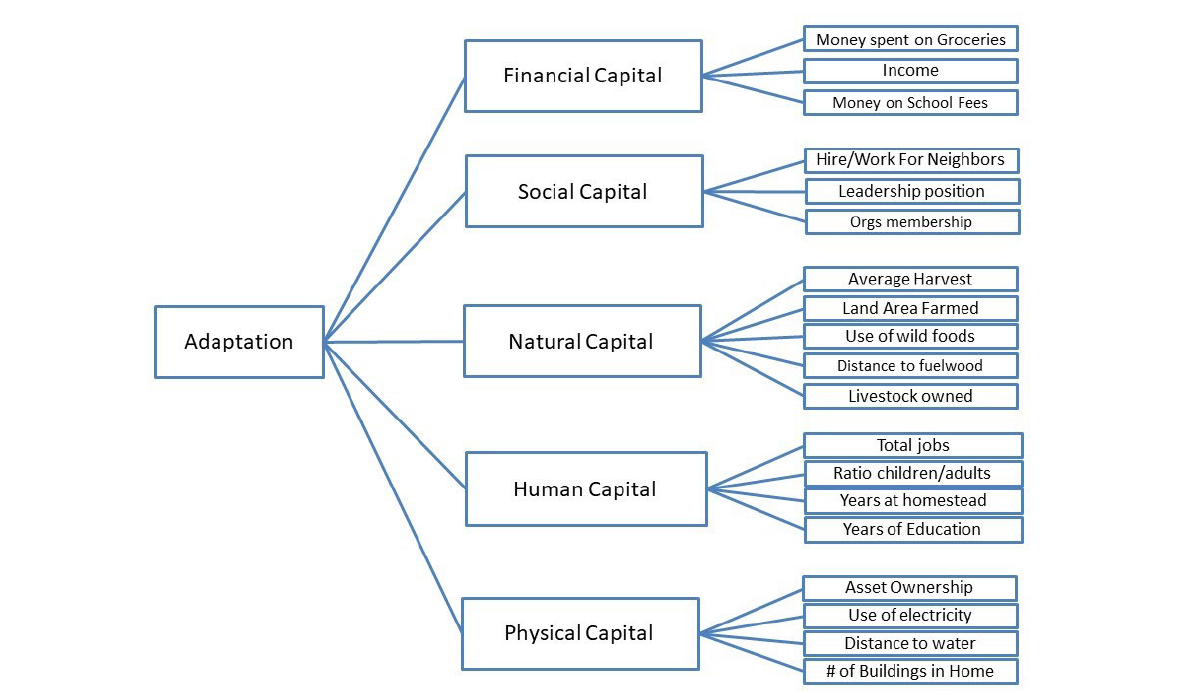
Fig. 2. Diagram of the five types of capital hypothesized to influence adaptation and their indicator measures.